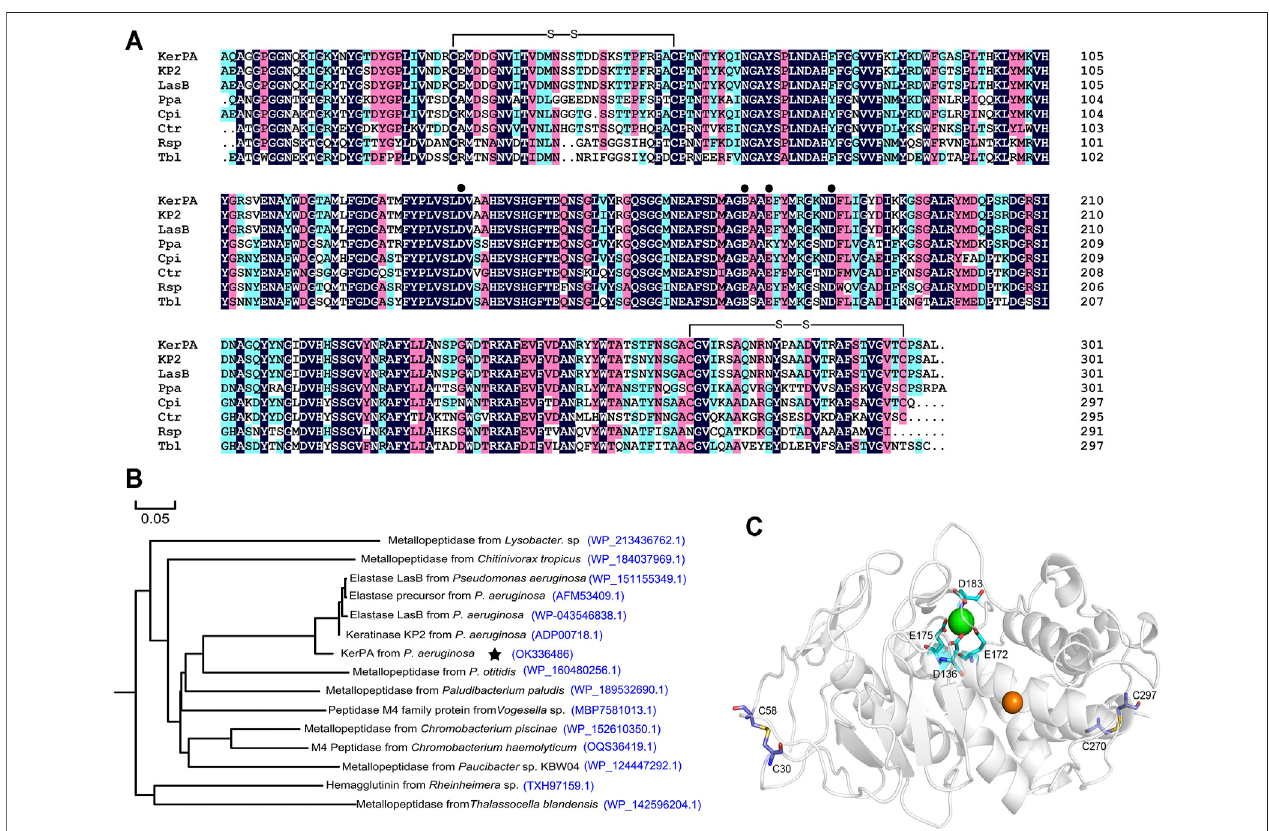
FIGURE 1 | Sequence and structure analysis of keratinase from Pseudomonas aeruginosa (KerPA). (A) Multiple sequence alignment of KerPA and its homologs. Catalytic domain of KerPA from Pseudomonas aeruginosa isolated in this study is aligned with keratinase KP2 from P. aeruginosa (accession number: ADP00718.1), elastase LasB from P. aeruginosa (accession number: WP_043546838.1), metallopeptidase Ppa from Paludibacterium paludism (accession number: WP_189532690.1), metallopeptidase Cpi from Chromobacterium piscinae (accession number: WP_152610350.1), metallopeptidase Ctr from Chitinivorax tropicus (accessionnumber:WP_184037969.1),Rspfrom Rheinheimera sp(accessionnumber:TXH97159.1),andmetallopeptidaseTblfrom Thalassocellablandensis (accession number: WP_142596204.1). Filled circles show calcium ion ligand residues. Two disulphide bonds are shown as black lines. Alignments were generated using clustalX2 programandcolouredusing DNAMAN5.2.2software. Conserved residuesinallsequencesareindicted byblackbackground. (B) Phylogenomictreeof KerPA. Setof15keratinaseproteinswithhighhomology